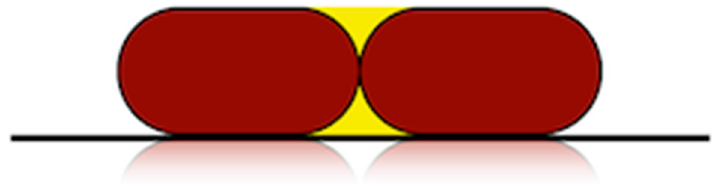
Figure 1. Schematic of the cross-section of two adjacent deposited filaments with print orientation angle of 0° (the horizontal line corresponds to the printing bed) . angle of 0 ◦ (the horizontal line corresponds to the printing